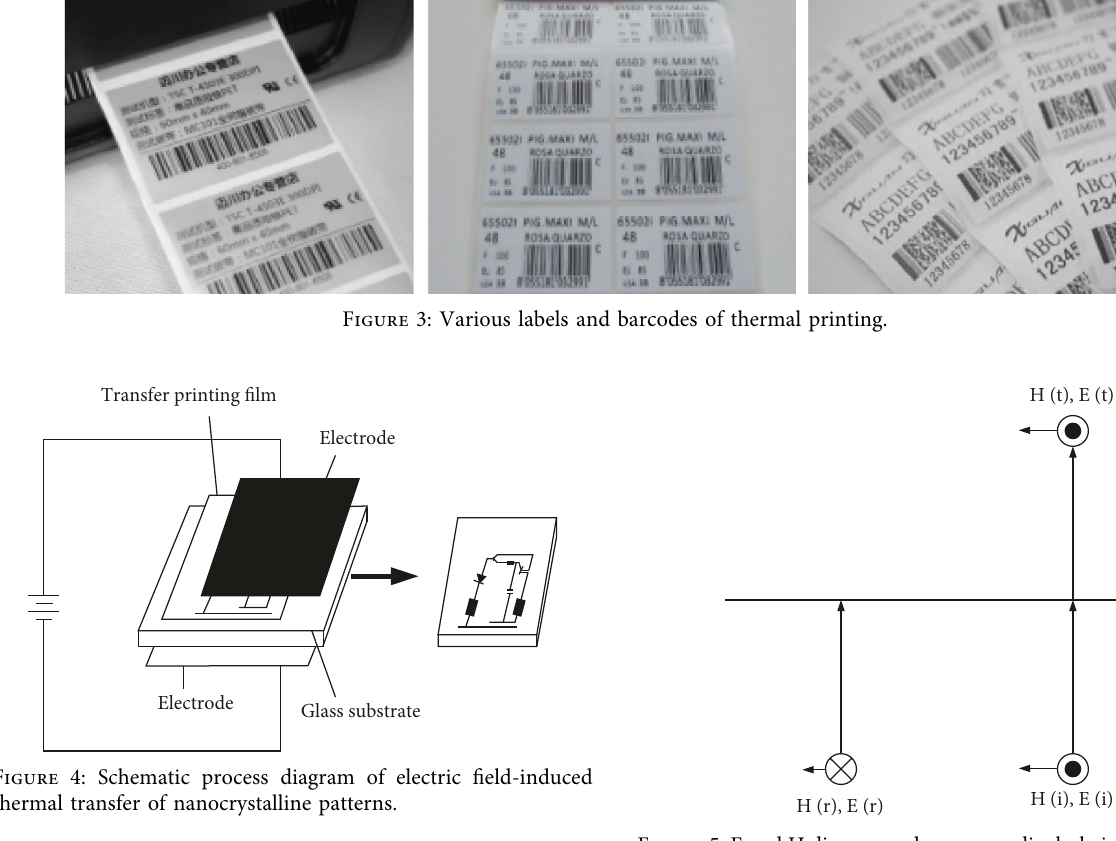
Figure 5: E and H diagrams when perpendicularly incident on the ink absorption